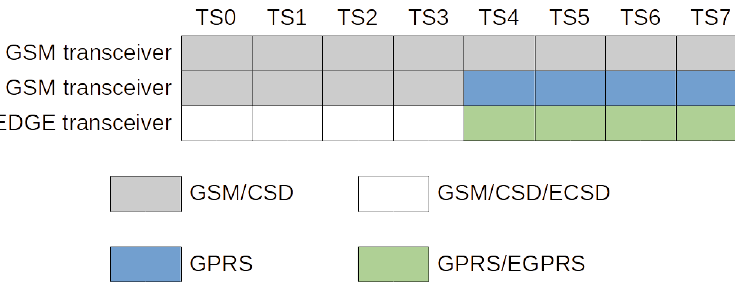
Figure 3. Examples of time slot allocations in different transceivers; time slots used for control signaling are not included in the